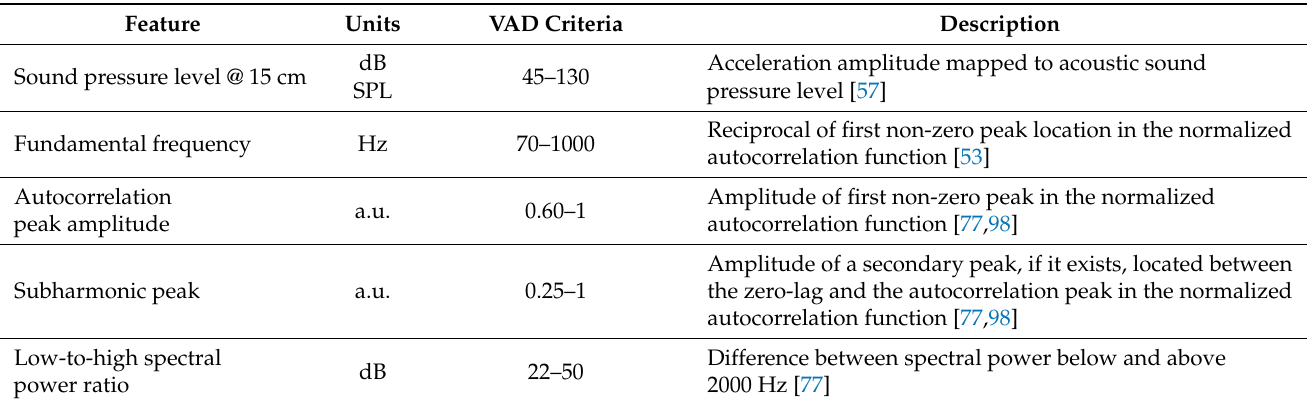
Table 3. Description of accelerometer-based features and voice-activity detection (VAD) range criteria for each feature computed on in-field ambulatory voice data to determine whether a 50-ms frame was considered voiced or